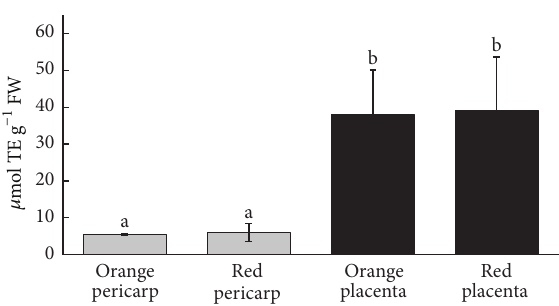
Figure 3: Total CUPRAC antioxidant activity in pericarps and placentas of two ripe C. chinense Jacq. accessions. Values are mean ± SEM, 𝑛 ≥ 3 . Differences are significant at level 𝑃 < 0.05